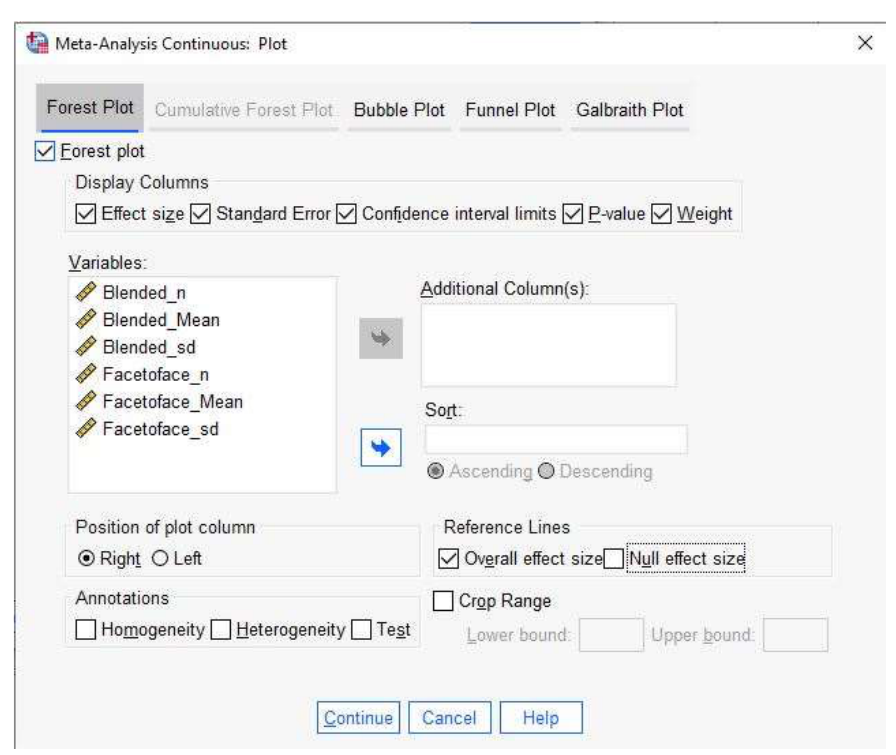
Figure 5. Data Identification Menu.